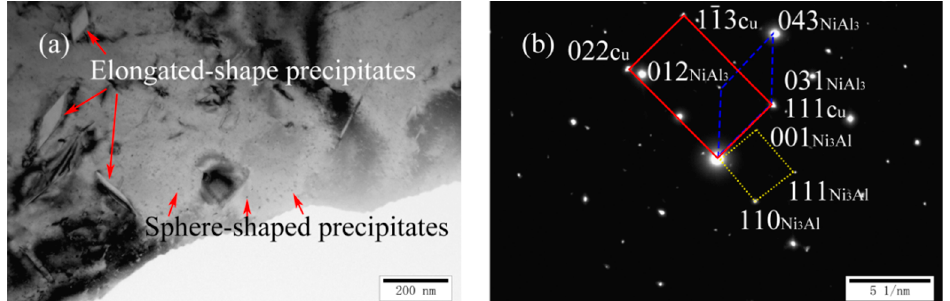
Figure 6. Microstructures of cast Cu-7Ni-7Al-1Fe-1Mn alloy: ( a ) bright-field image; and ( b ) the corresponding SADP of ( a ).